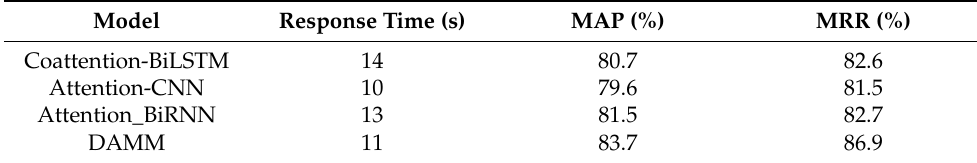
Table 5. Response time and precision of four network